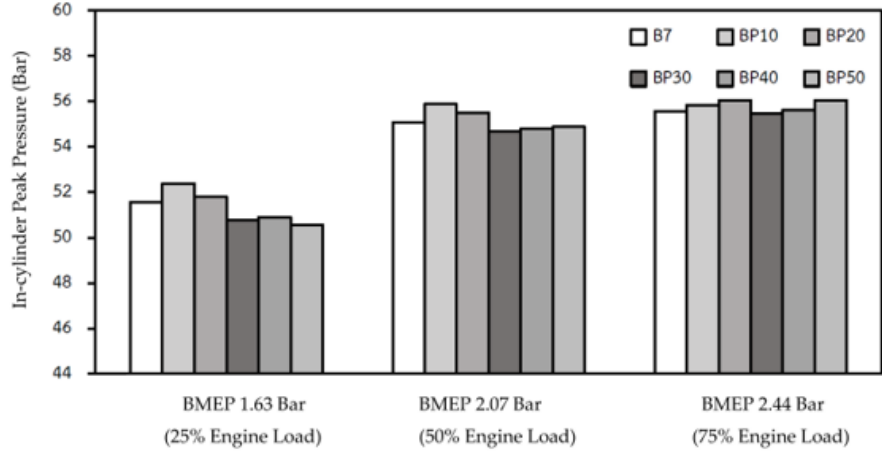
Figure 2. In-cylinder pressure profile and heat release rate in the combustion process with ( a ) a BMEP of 1.63 bar (25% engine load); ( b ) a BMEP of 2.07 bar (50% engine load); and ( c ) a BMEP of 2.44 bar (75% engine load).